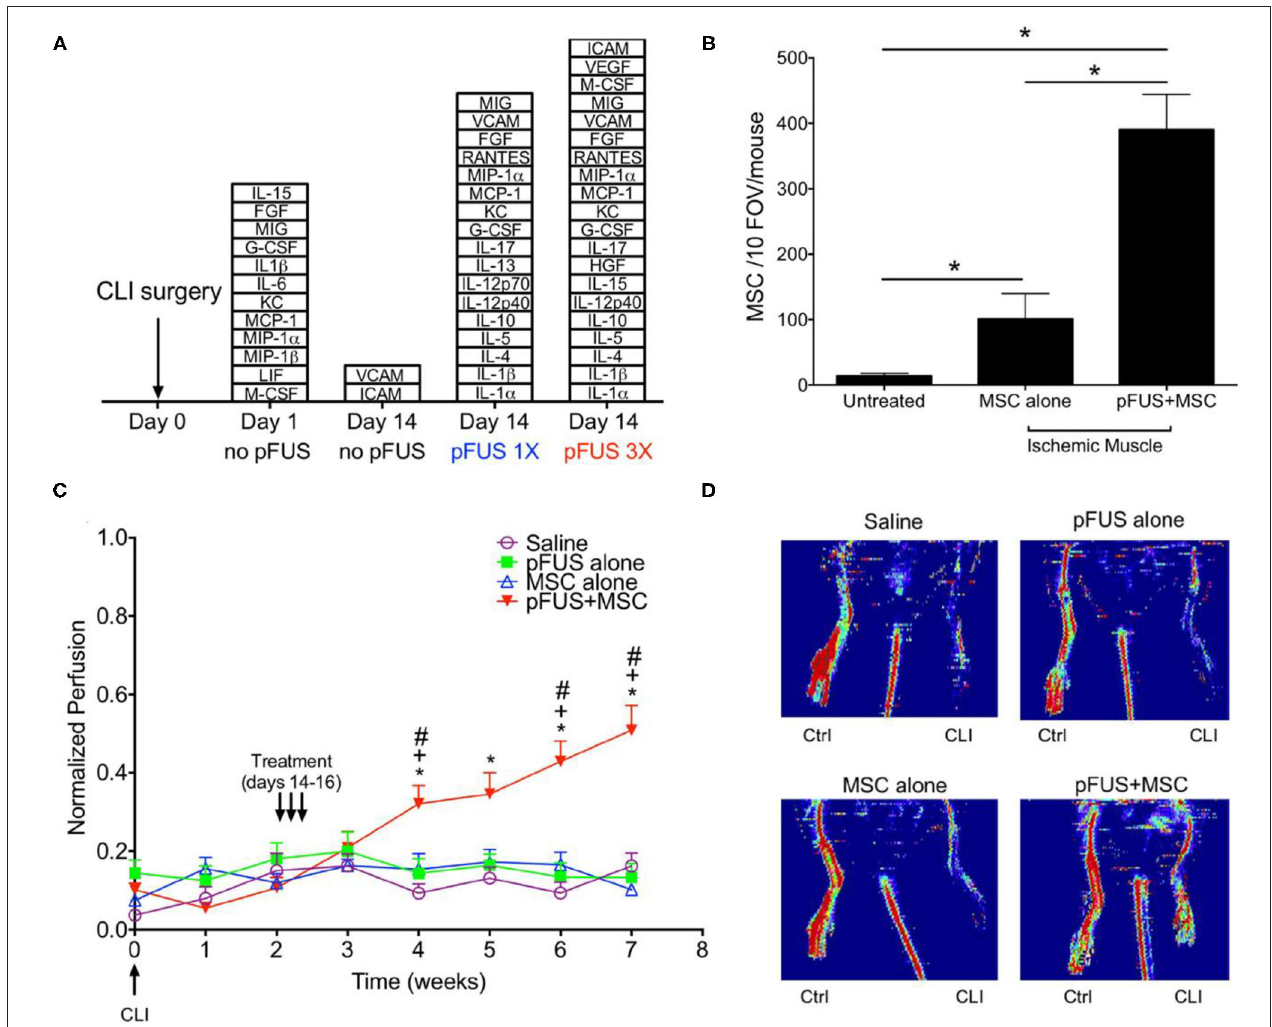
FIGURE 4 | FUS mediated delivery of MSCs in murine model of CLI in skeletal muscle (A) Stacked box plots comparing proteomic responses of CLI muscle between FUS treatment and untreated controls. The chemokines, cytokines, trophic factors, and cell adhesion molecules listed are those have significantly higher levels than those in normal muscle after CLI alone ( n = 6). (B) SPION labeled MSCs in control and FUS treated skeletal muscle in CLI mice. Significantly greater numbers of MSCs were observed in FUS treated animals, based on Prussian blue staining of cells ( n = 5). (C) Temporal changes in normalized perfusion comparing control and FUS treated CLI mice. Results are based on laser Doppler perfusion imaging (LDPI) indicating reperfusion that occurred in FUS treated animals only ( n = 7). (D) Representative LDPI images at week 5 in the study for each experimental group. Adapted from Tebebi et al. Sci Rep 2017 (91). Reprinted with permission from Nature Research